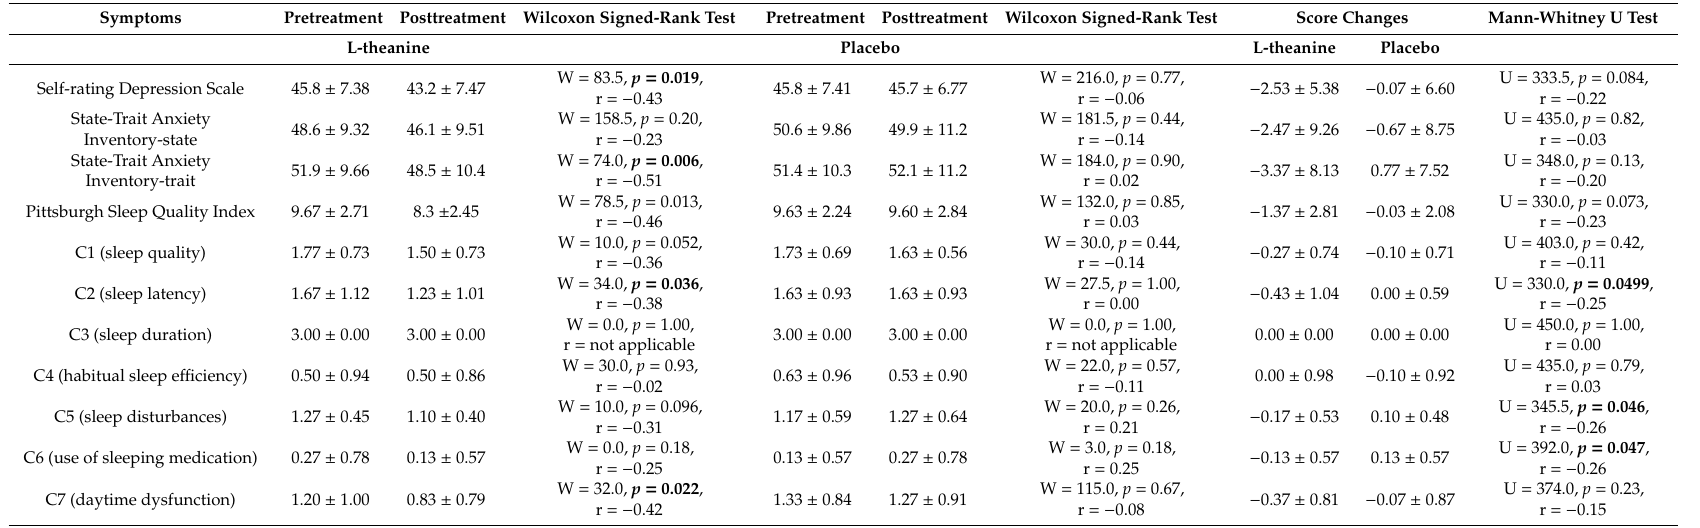
Table 2. The stress-related symptom scores after 4 weeks L-theanine or placebo